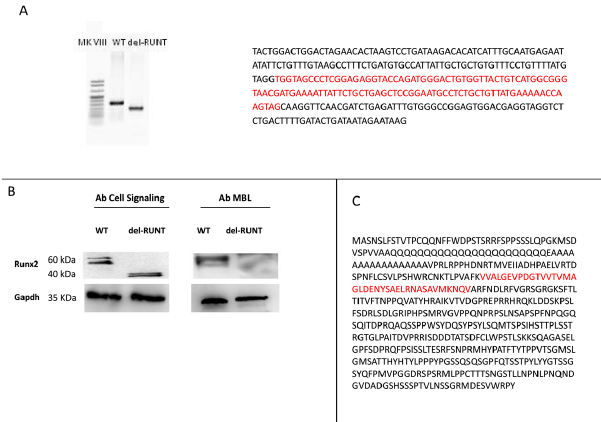
Figure 4. A clone with an in-frame 114 bp deletion in the RUNT domain was obtained by CRISPR/Cas9. On the left, agarose gel showing PCR products (WT: 340 and del-Runt 226 Bp). On the right, the Sanger sequence of the PCR products with the 114 bp deletion highlighted in red. ( A ) Western Blot (WB) of RUNX2 in WT and del-RUNT cells. A shorter protein lacking 38 residues was observed by using the antibody produced by Cell Signaling manufactures; No Runx2 protein was detected in del-Runt cells by using the MBL antibody in WB ( B ); On the right, the Runx2 protein sequence (UniProtKB/Swiss-Prot: Q13950.2); the 38 aa deletion is highlighted in red in the protein context ( C ).